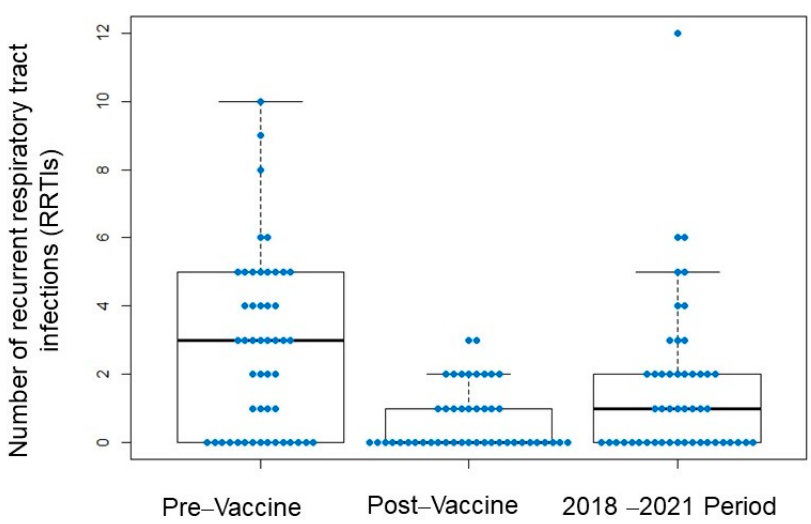
Figure 2. Incidence of recurrent urinary tract infections (RUTIs).